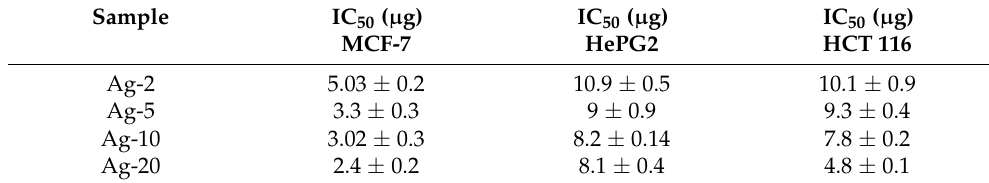
Table 2. The IC 50 ( µ g) of the prepared Ag-b-SiO 2 samples against different human solid tumor